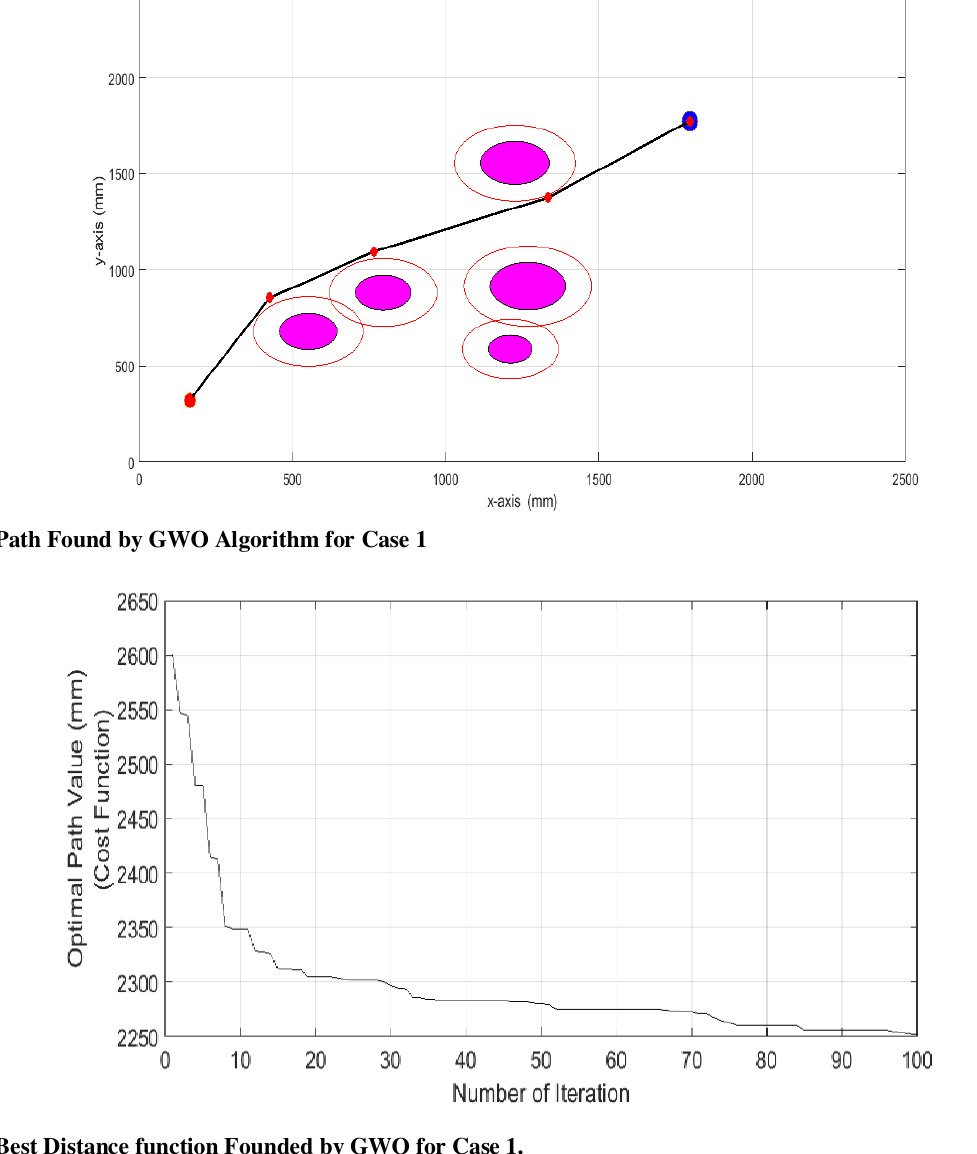
Fig. 5. Best Distance function Founded by GWO for Case